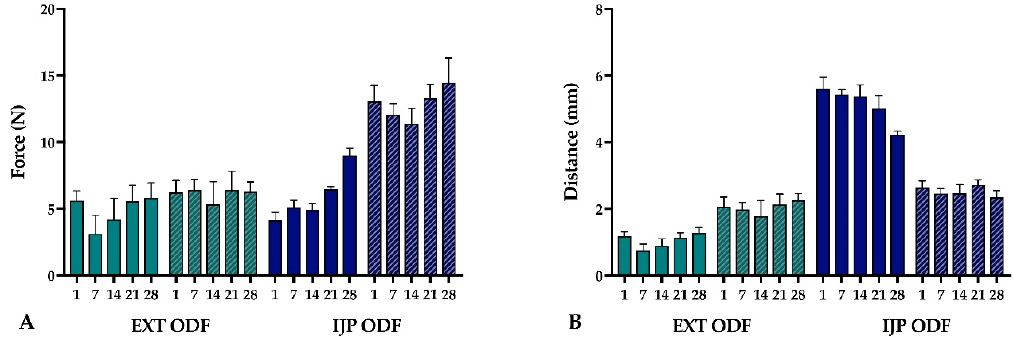
Figure 4. ( A ) Burst strength representing the maximum force (N) and ( B ) burst distance representing the elongation (mm) of the ODF before rupturing. Drug-loaded ODFs are shown as colored columns and placebo ODFs are presented as colored columns with a pattern. Data is shown as average ± SD, n = 5 for each time point.